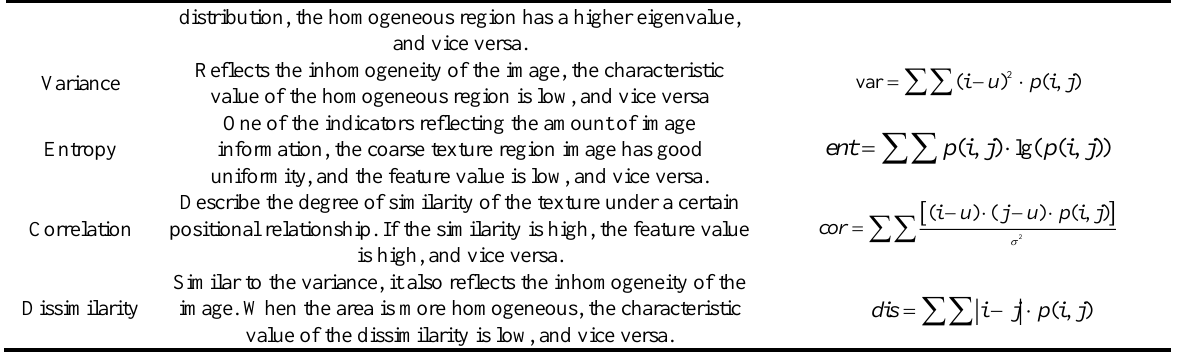
Table2 GLCM Texture feature statistics (Li et al., 2015; Chen et al., 2013)